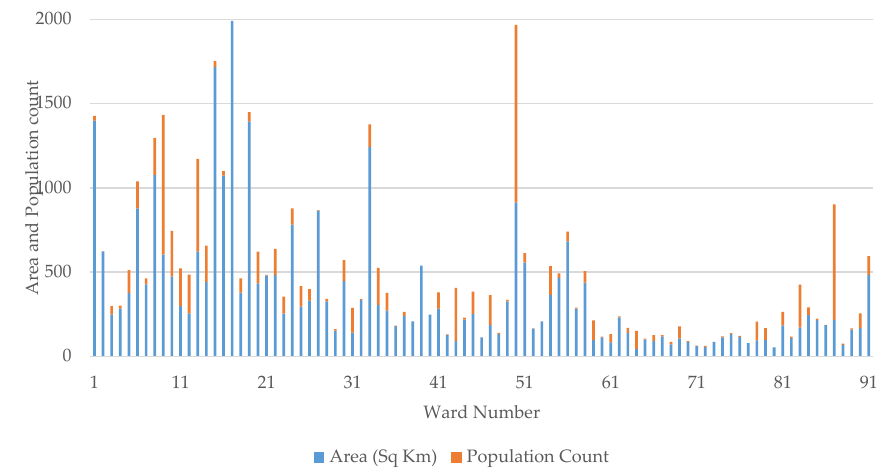
Figure 11. The figure shows the pattern of the population count predicted from the dasymetric model against the ward size. No pattern is found between ward size and population